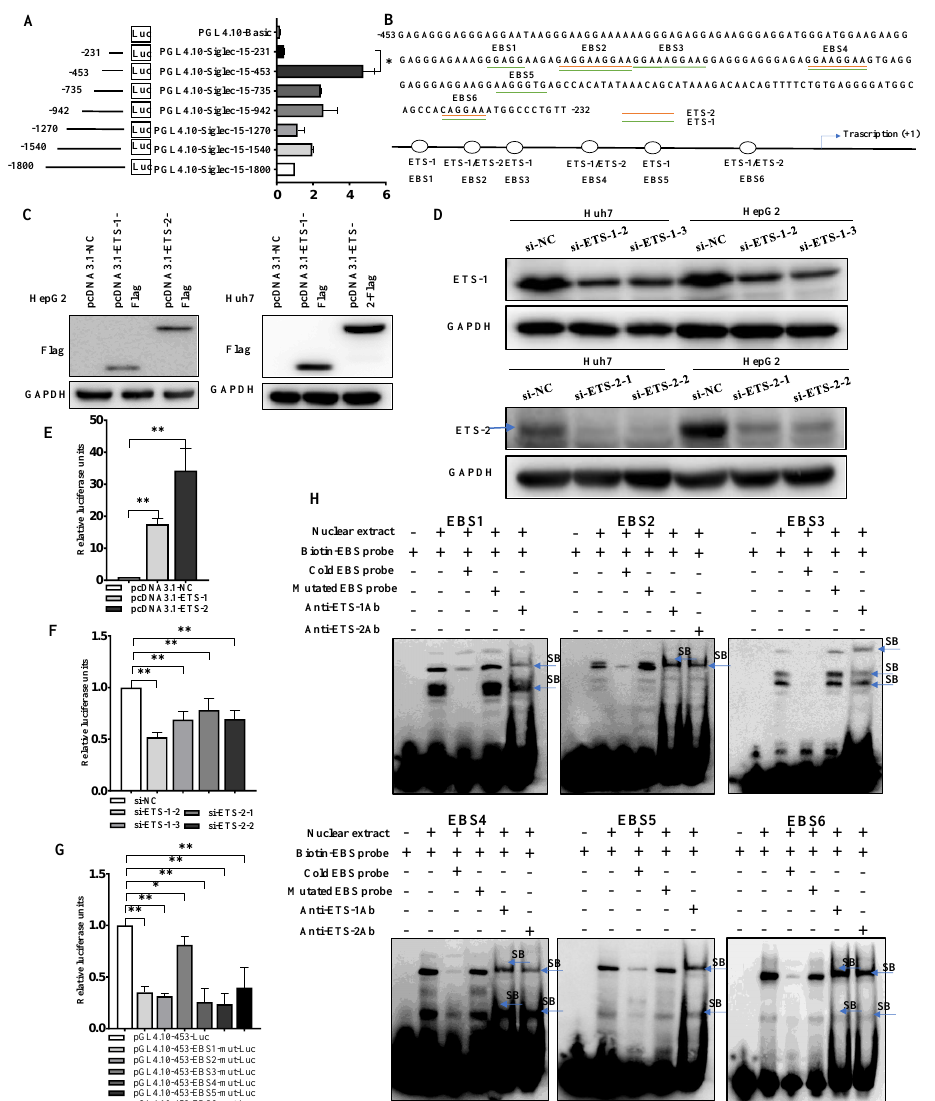
Figure 2. Putative transcription factors and binding sites in the Siglec-15 promoter. ( A ) Activity analysis of the Siglec-15 promoter. HepG2 cells were transfected with each of the Siglec-15 promoter constructs and pRL-TK. The relative luciferase units (RLU) were obtained by comparison with the full-length Siglec-15 promoter construct (pGL4.10-1800-Luc). Each transfection was performed in duplicate and the data are expressed as mean ± SD of three independent experiments. ( B ) Nucleotide sequence of the − 453 to − 232 region of the Siglec-15 promoter. The six putative binding sites of ETS-1 and ETS-2 were underlined in the sequence and schematically depicted below. ( C , D ) Western blot analysis of ETS-1 and ETS-2 expression in HepG2 and Huh7 cells with ETS-1 or ETS-2 overexpressed ( C ) or knocked down ( D ). ( E , F ) Luciferase activities in the cells with ETS-1 or ETS-2 overexpressed ( E ) or knocked down ( F ). ( G ) Effect of EBS mutations on Siglec-15 pGL4.10-453 promoter activity. EBS mutants (0.25 µ g) together with 10 ng of pRL-TK were co-transfected into HepG2 cells. The RLU were obtained by comparison with the wild-type pGL4.10-453-Luc. ( H ) Electrophoretic mobility shift assays with specific antibodies against ETS-1 and ETS-2. Arrowheads indicate the shift band (SB). The biotin-labeled probe was incubated in the absence (Lane 1) or presence (Lane 2) of nuclear extracts from HepG2 cells; unlabeled cold probe (Lane 3) and mutated probe (Lane 4) were used as competitor at a concentration of 100-fold molar excess to biotin-labeled probe. Super-shift assays were carried out with 8 µ g specific antibody raised against ETS-1 or ETS-2 (Lane 5 or Lane 6). * p < 0.05; ** p < 0.01. NC stands for negative